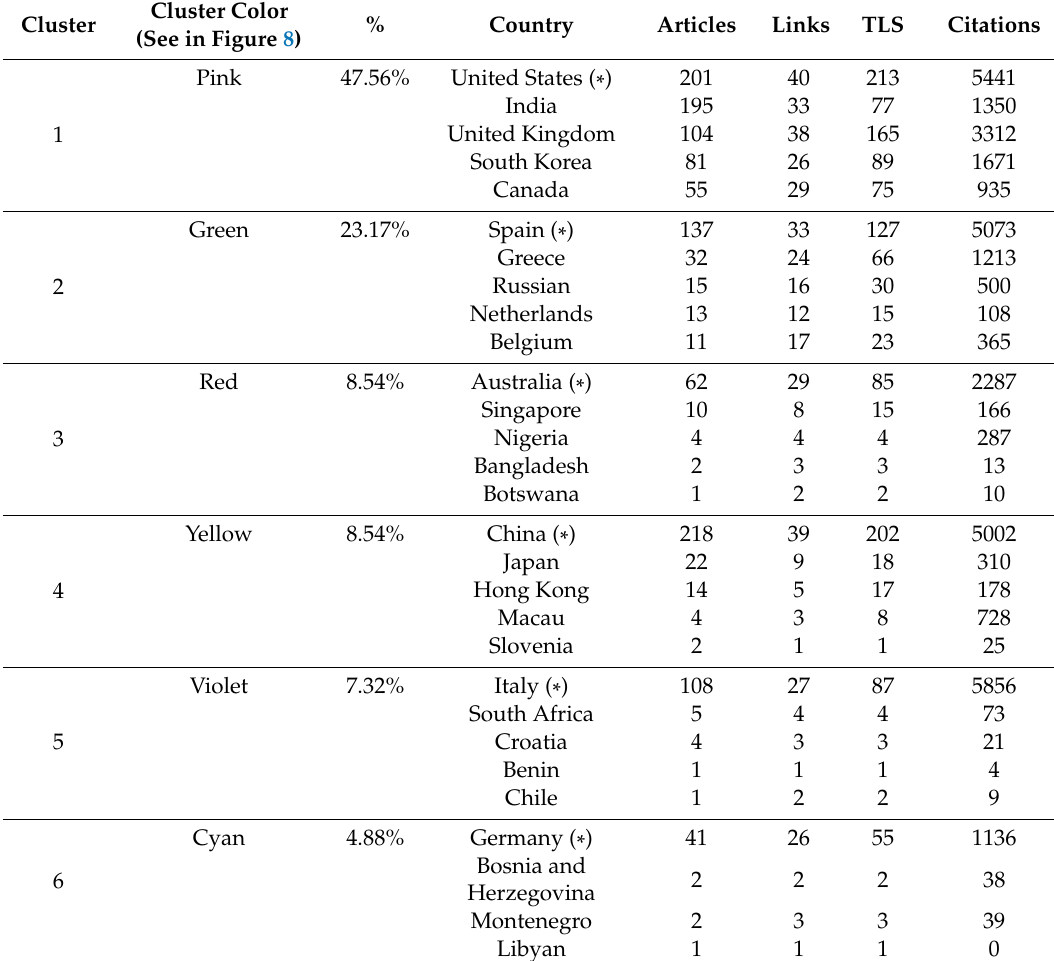
Table 16. Clusters of countries